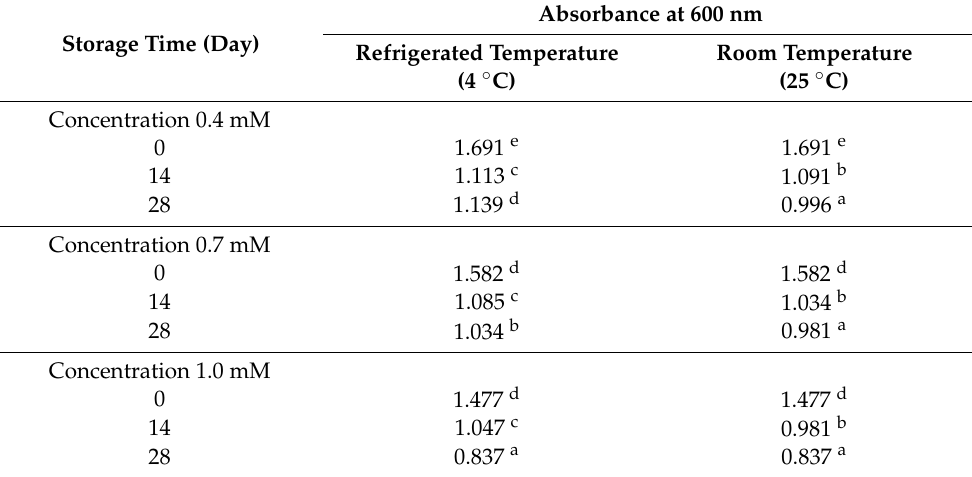
Table 3. Resistance to hydrogen peroxide of Lactobacillus fermentum InaCC B1295 in CMFH-OPEFB at different temperatures for 28 days of